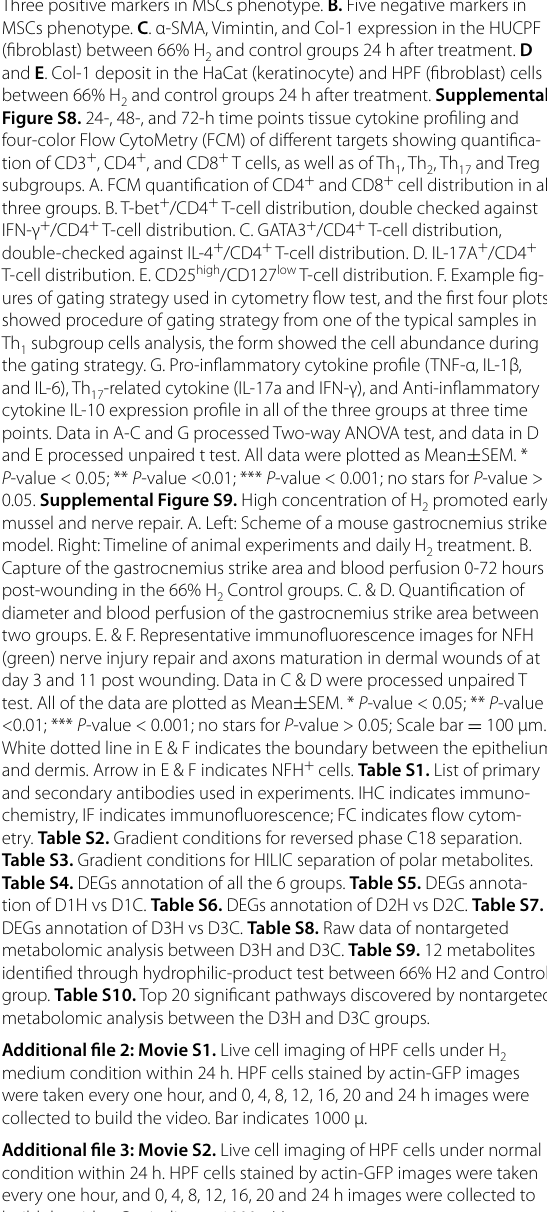
Figure S5. Transcriptomics and metabolomics correlation analysis reveal that differential genes and metabolites of the D3H group are enriched in tight junction and focal adhesion pathways. A. Correlation plot of DEGs and differential metabolites between D3H and D3C. B. Count of D3H vs D3C DEGs enriched in KEGG pathways. Supplemental Figure S6. ECM components col-I, fibronectin, laminin, and integrin deposition 2 days